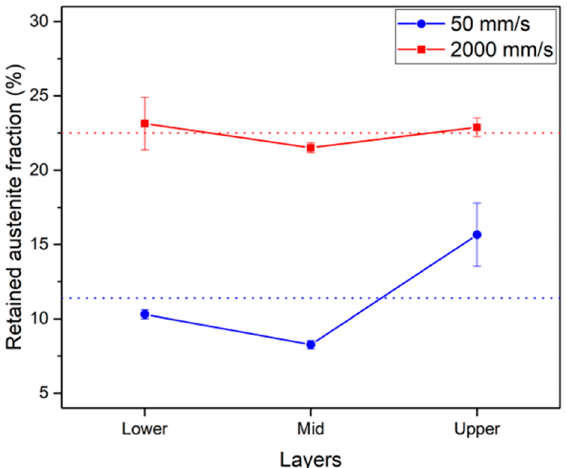
Figure 6. Average fraction of retained austenite according to the regions and the scan speeds of the AM objects (the error bars and the broken horizontal lines represent the standard errors and the average values for the whole sampled regions, respectively).